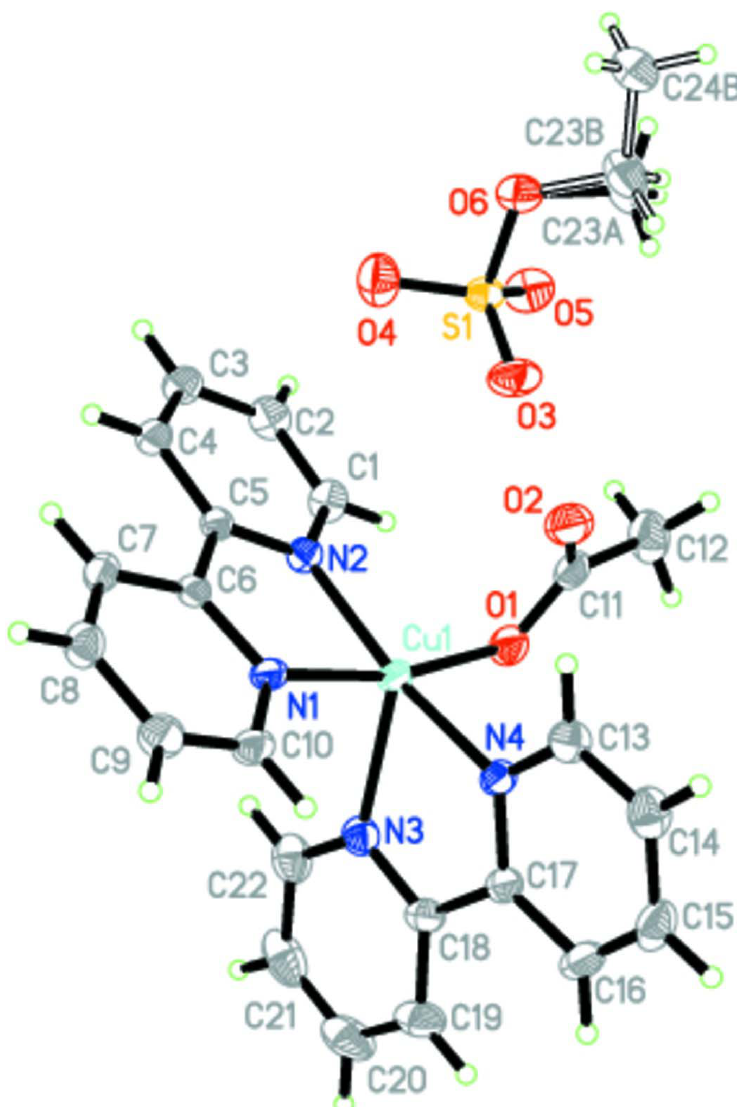
Figure 1 The molecular structure with displacement ellipsoids at the 30% probability level. The disorder is shown as open